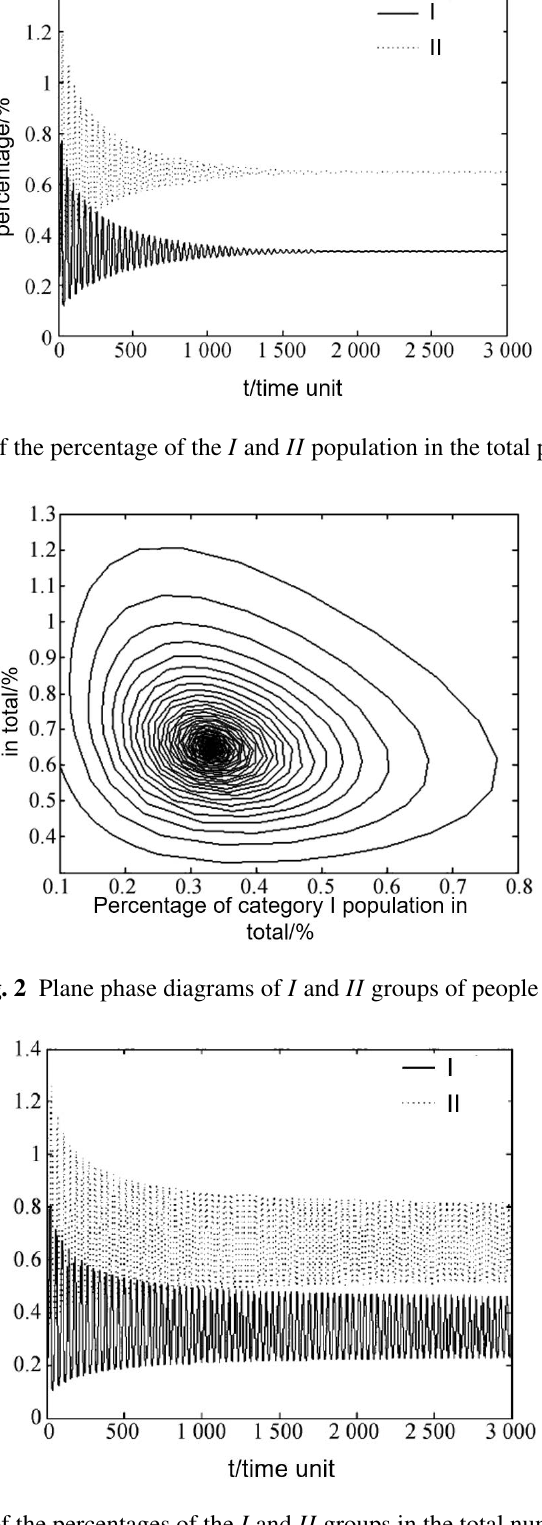
Fig. 3 Waveform diagram of the percentages of the I and II groups in the total number of people over